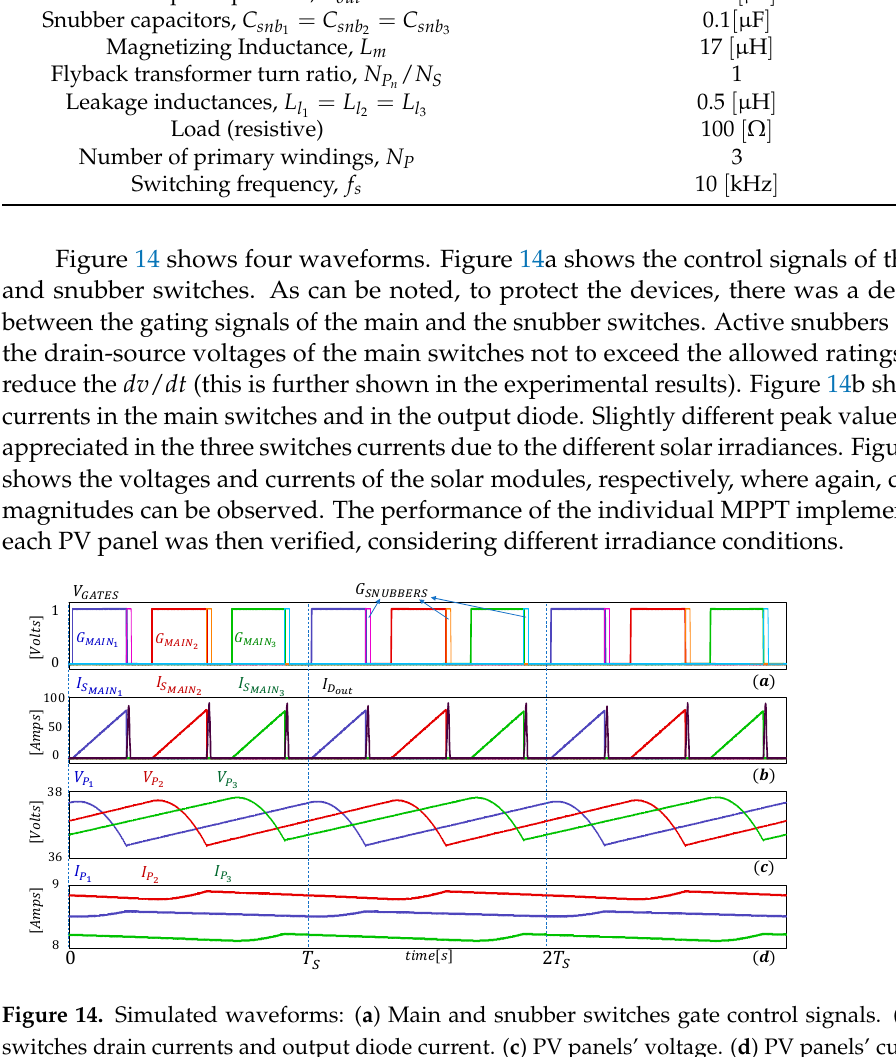
Table 1. Simulation parameters.